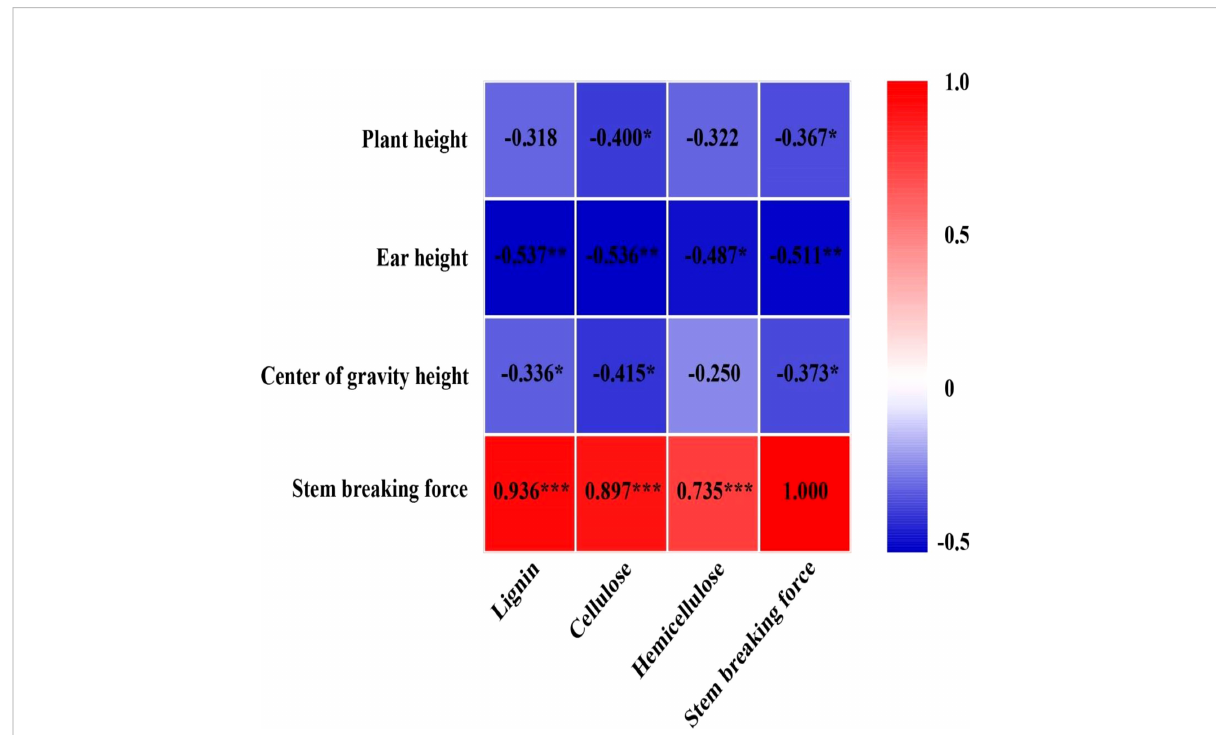
FIGURE 7 Relationship between cellulose, hemicellulose, lignin, and stem-breaking force with plant height, ear height, center of gravity height, and stem- breaking force in 2021 ( n = 12 ). The numbers in the fi gure represent R 2 , the coef fi cient of determination. “ − ” represents a negative correlation between the two indicators. R 2 > 0.4 and P < 0.05 indicate a signi fi cant relationship. *, ** and *** indicate signi fi cant differences at P< 0 . 05, 0.01 and 0 . 001 , respectively. The data used for the regression analysis are the mean values under each